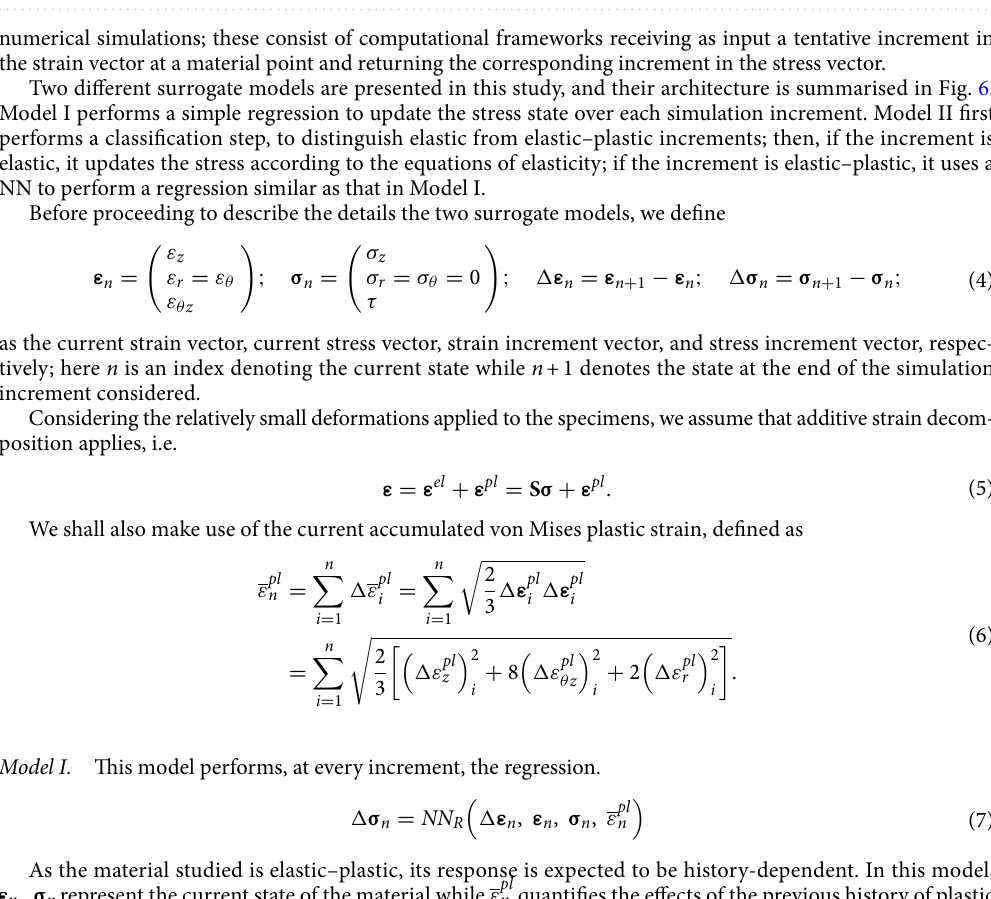
Figure 6. Schematic of the two surrogate